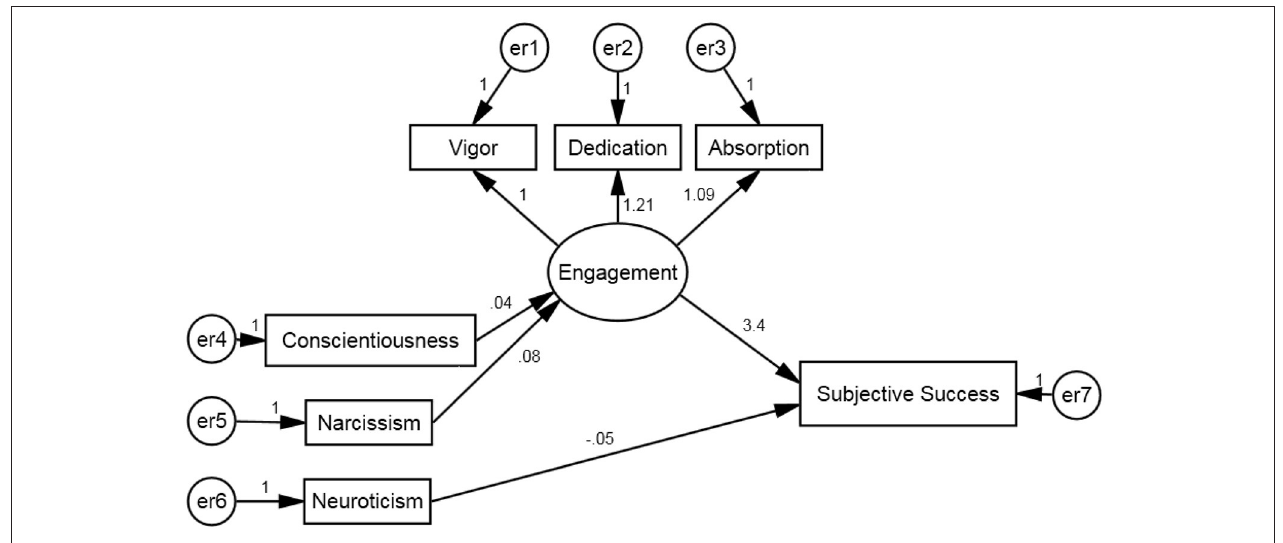
FIGURE 1 | SEM predicting Subjective